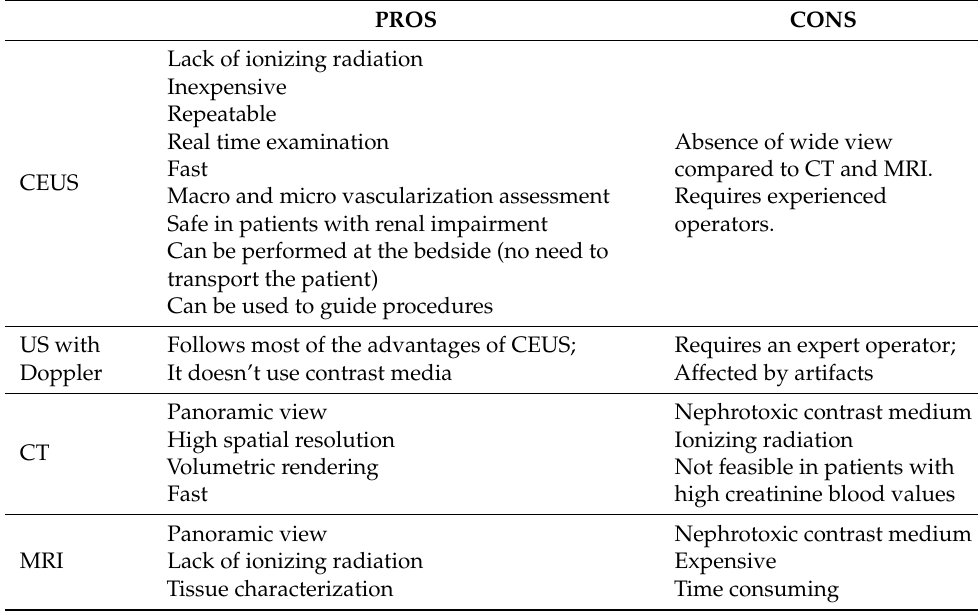
Table 3. Comparison of Pros and Cons for CEUS, US Doppler, CT, and